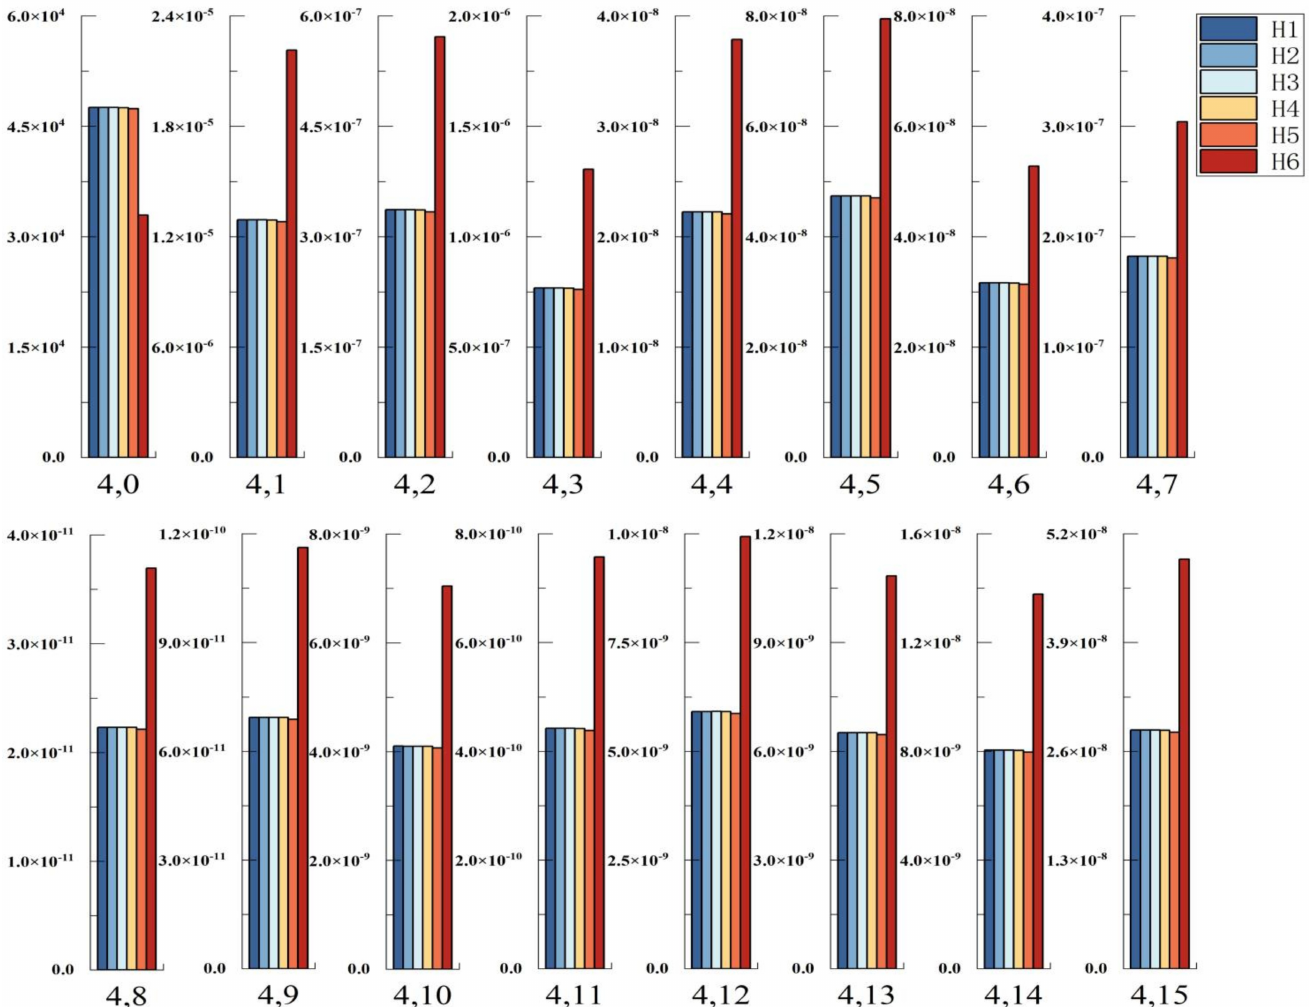
Figure 23. Characteristic energy of piston side pressure wavelet packet when reversing valve